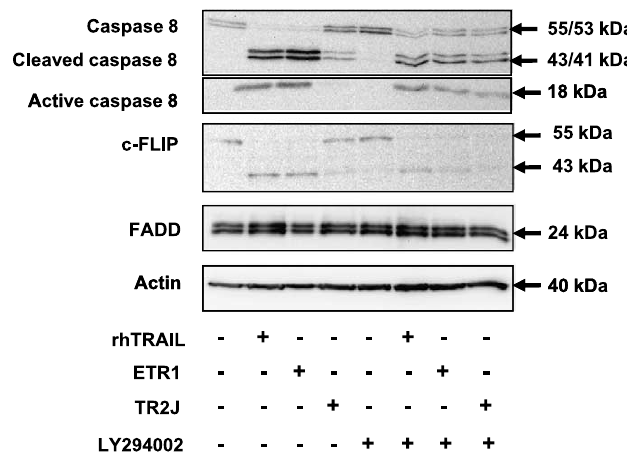
Fig. 4. PI3K inhibition modulates DISC proteins cleavage and surface DR4 levels, but not cell membrane localization of DR5 or initial DR5-DISC formation. (A) Expression levels of several proteins located downstream of the TRAIL receptors were determined by Western blotting in SW948. The cells were pre-incubated for 15–18 h with 20 µM LY294002, then either left untreated or exposed for 3 additional hours with rhTRAIL (0.1 µg/ml), HGS-ETR1 (50 nM) or HGS-TR2J (50 nM) before harvest. (B) Surface expression of TRAIL receptors in SW948 and SW948-TR, in control cells and after 15–18 h exposure to 20 µM LY294002. Receptor expression was detected as the average antigenic density of the whole cell population (Black line histograms: fluorescence of the untreated cells, grey shaded histograms: fluorescence of the cells treated with 20 µM LY294002 for 15–18 h). (C) Fluorescent microscopy imaging of DR5 in SW948 cells in untreated cells and cells exposed with 20 µM LY294002 for 17 h, stimulated or not with HGS-TR2J for 15 min. Cells were first pretreated with LY294002 and stained for cell membrane DR5. Next, cells were either kept on ice or treated with HGS-TR2J for 15 min at 37 ◦ C before fixation. One representative of at least three independent experiments is shown. (D) DR5-DISC immunoprecipitation in SW948 cells, using the HGS-TR2J antibody. Cells were pretreated or not for 17 h with 20 µM LY294002 before stimulation for 15 min using HGS-TR2J and immunoprecipitation with protein G agarose (C – antibody added after cell lysis, T – cells treated with HGS-TR2J). DR5-DISC analysis was performed at least three times. (Colors are visible in the online version of the article;